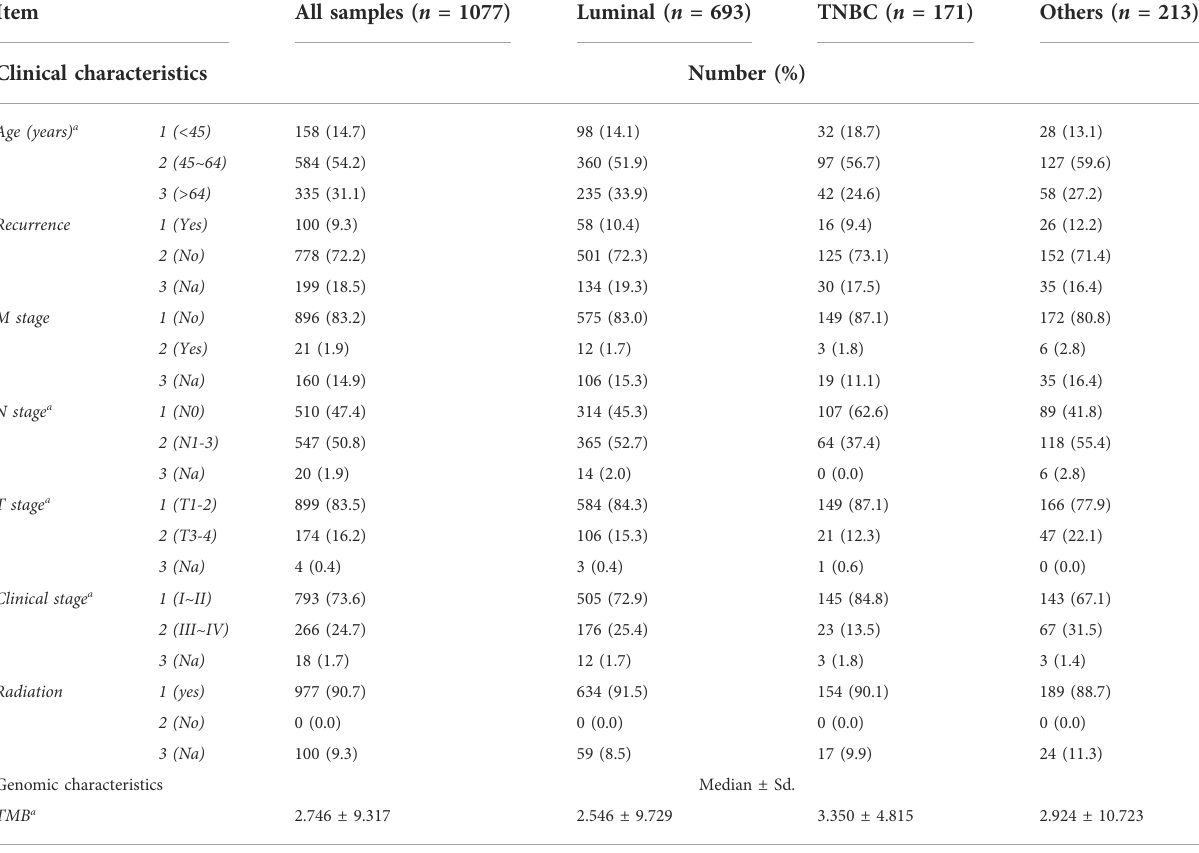
TABLE 1 | Clinical and genomic characteristics of subtypes of breast cancers. (1) Data from TCGA, from which the total sample was 1077 records, the luminal cohort was 693 records, the TNBC cohort was 171 records, and the other cohort was 213 records. (2) The asterisk * means that factors whose proportion of subtypes was < 10% were selected for further